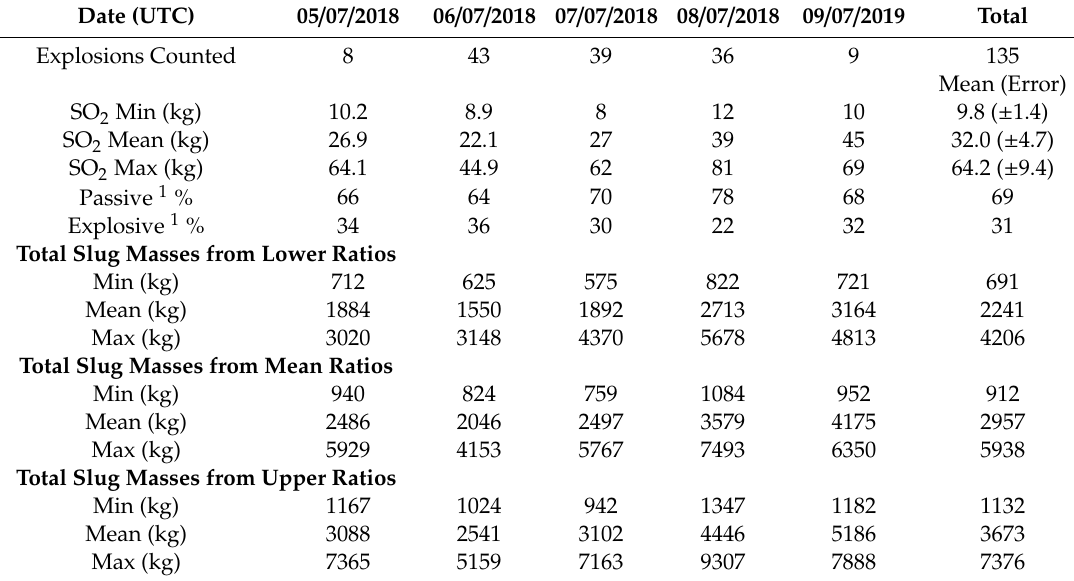
Table 3. A breakdown of daily SO 2 explosion mass data. Also displayed are percentages indicating the partitioning of gas masses between passive and explosive degassing. Below this the total gas slug masses are shown, where lower and upper ratios refer to the ranges indicated in determined active molar ratios by Woitischek et al. (Table 3; CO 2 / SO 2 = 2.85 ± 0.17; H 2 O / SO 2 = 315 ± 71.8; SO 2 / HCl = 1.6 ±